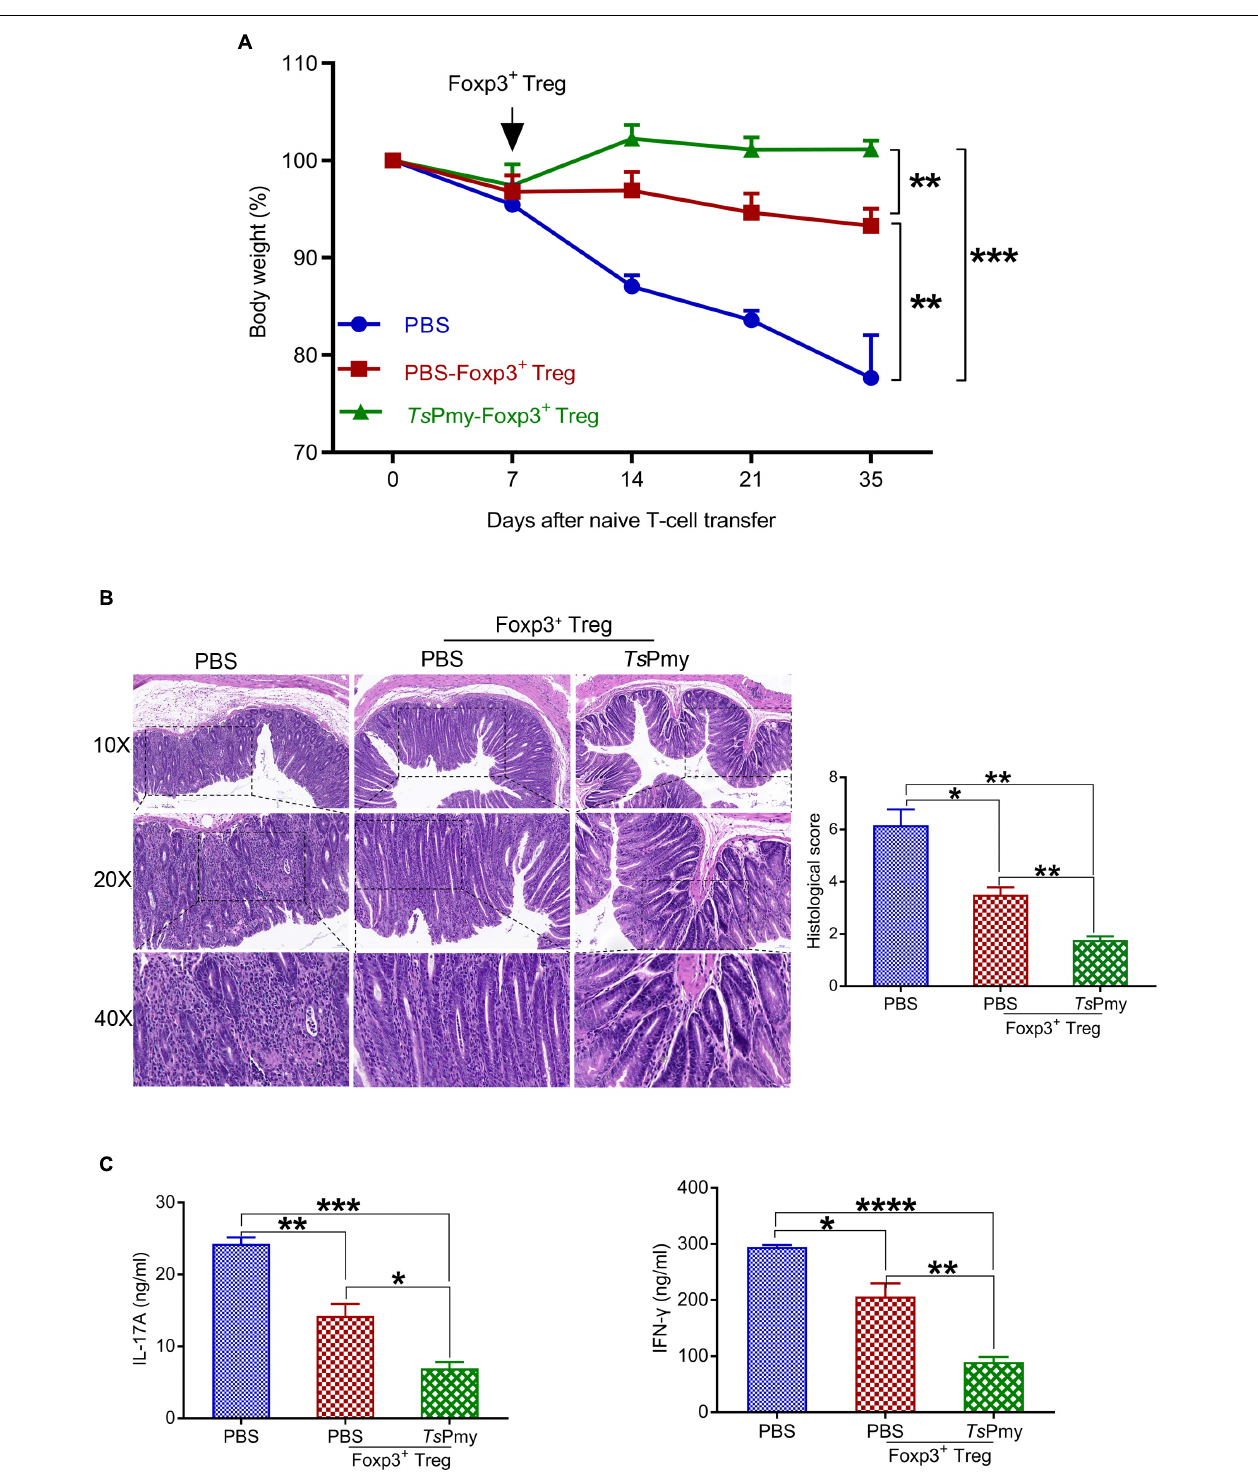
FIGURE 8 | Adoptive transfer of r Ts Pmy-induced Tregs reduces the pathology and inflammation of naïve T-cell-induced colitis in Rag1 KO mice. (A) Changes in body weight ( n = 3). (B) Hematoxylin and eosin (H&E) images of the distal colon at objective 10x, 20x, and 40x at 4 weeks after adoptive transfer of r Ts Pmy- or PBS-treated cLP Tregs compared to Rag1 KO mice receiving PBS. Histological scores of each group are displayed on the right ( n = 3). (C) IL-17A and IFN- γ production of LPMCs in recipient Rag1 KO mice stimulated with anti-CD3/CD28 mAb for 48 h was determined by ELISA ( n = 3). Data are presented as the mean ± SEM. * p < 0.05; ** p < 0.01; *** p < 0.001; **** p < 0.0001. LPMCs, Lamina propria mononuclear cells.